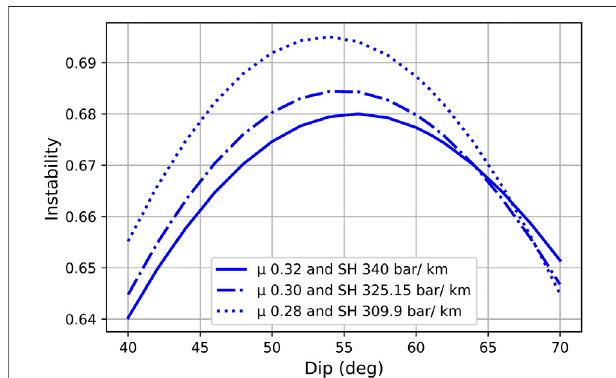
FIGURE8| InstabilityofPanterajaFaultatdipsof40 ° – 70 ° ,usingdifferent friction coef fi cients and SH magnitudes. The Sv, Sh magnitudes, SH orientation,andstrikeofPanterajaFaultarekeptconstant:Sv240 bar/km,Sh 180 bar/km,N39 ° E,and43.6 ° ,respectively.Thestressmagnitudesrefer to Hennings et al. (2012), while the stress orientation refers to Mount and Suppe